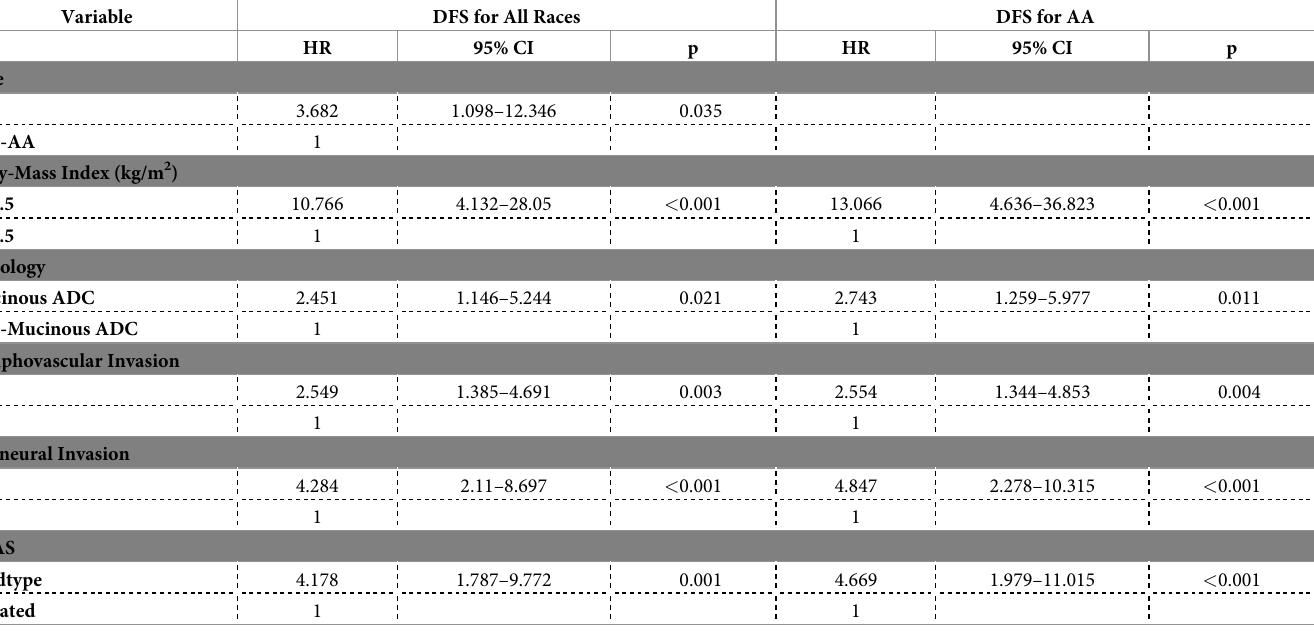
Table 4. Multivariate cox regression analysis for disease free survival (DFS) � .